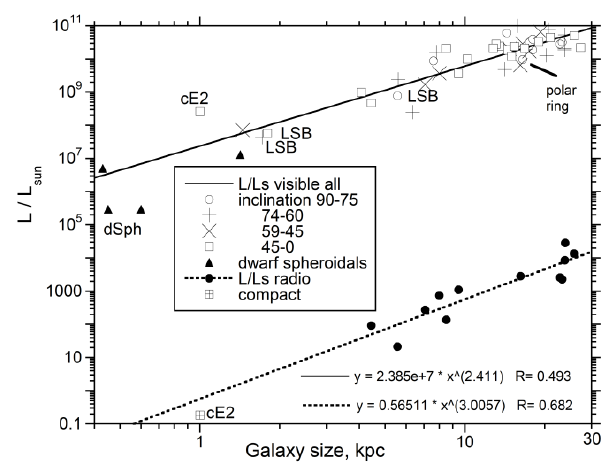
Figure 14. Dependence of luminosity in the visible and at 21 cm wavelengths on galaxy size, as determined from the visual edge at 25 B-magnitude arcsec − 2 . Data compiled in Table 4. Fits exclude the compact ellipsoid, M32.